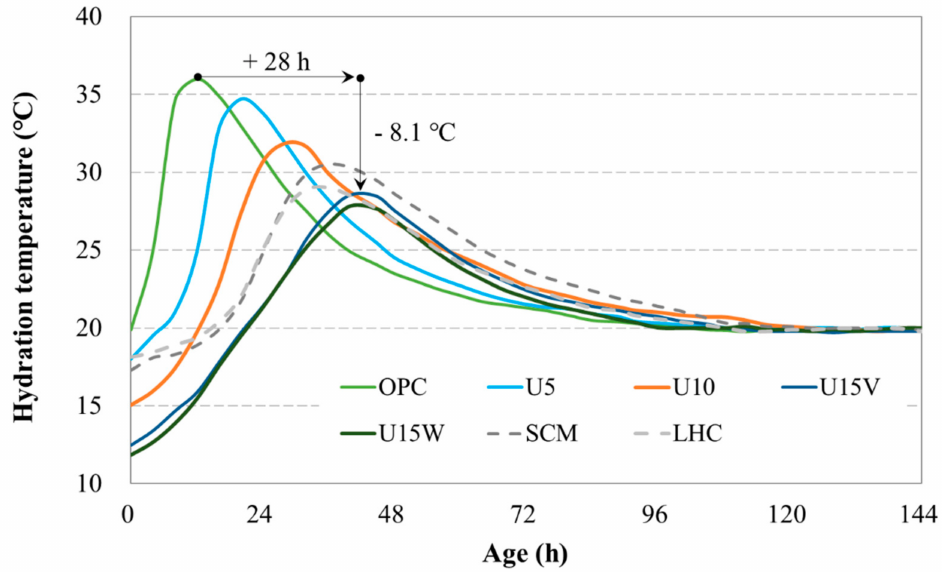
Figure 8. Hydration heat history of the concrete